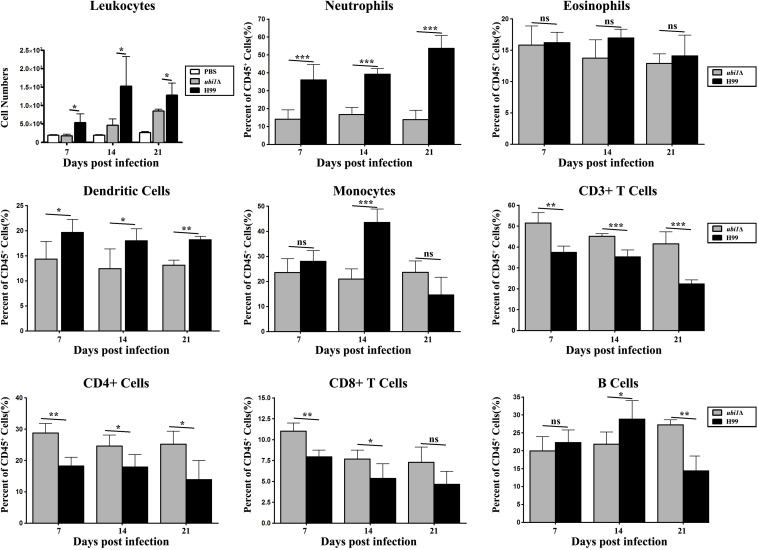
Ubi1 regulated pulmonary recruitment of leukocyte subsets during cryptococcal infection. Different leukocytes and lymphocytes from mice infected by C. neoformans were assessed by flow cytometry. Results represent mean ± SEM, N = 4 or more mice per group. *P < 0.05, **P < 0.01, ***P < 0.001; ns, no significant difference.